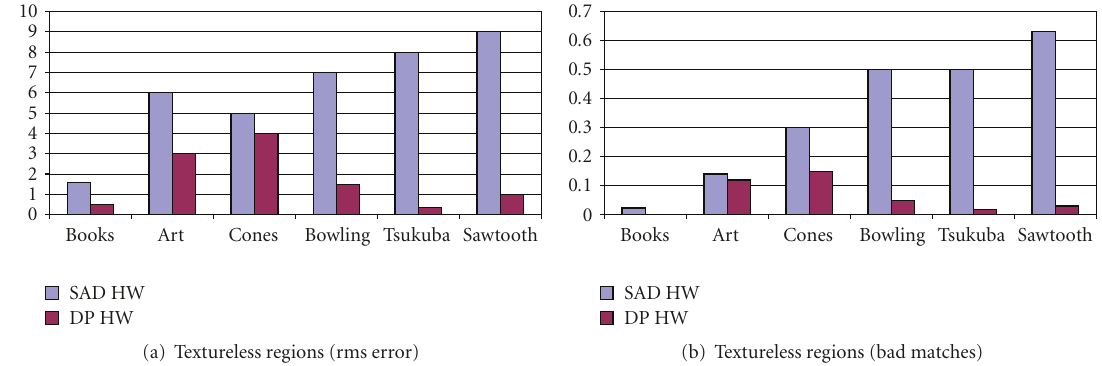
Figure 16: Errors computed in textureless regions for the various data-sets. (a) rms error, (b) percentage of bad matching pixels.